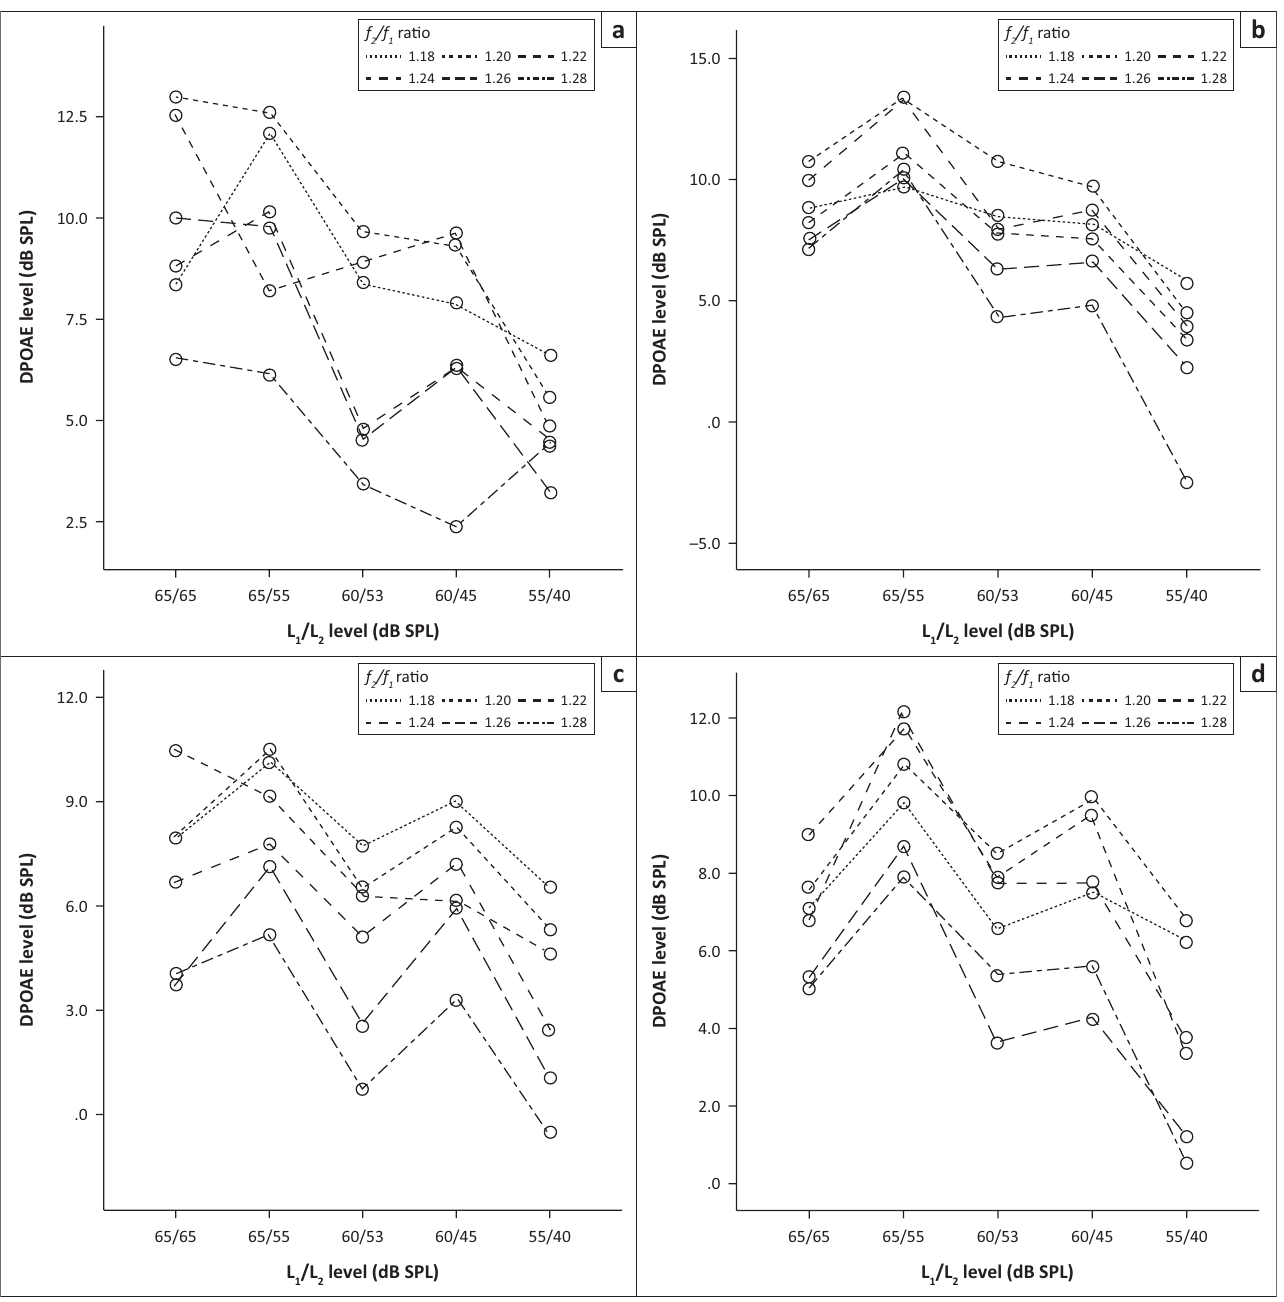
FIGURE 1: Mean distortion product otoacoustic emission absolute levels per intensity and frequency ratio combinations for each frequency ( f (b) left ear at 2003 Hz, (c) right ear at 2519 Hz, (d) left ear at 2519 Hz, (e) right ear at 3175 Hz, (f) left ear at 3175 Hz, (g) right ear at 3996 Hz, (h) left ear at 3996 Hz, (i) right ear 5000 Hz, (j) left ear at 5000 Hz, (k) right ear at 6996 Hz, (l) left ear at 6996 Hz, (m) right ear at 8003Hz and (n) left ear at 8003Hz. Hz,